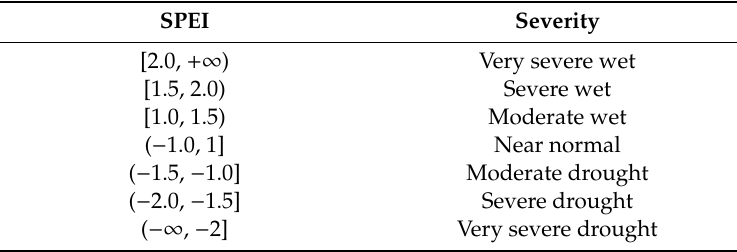
Table 1. Categorization of the drought and wetness severity by the standardized precipitation evapotranspiration index